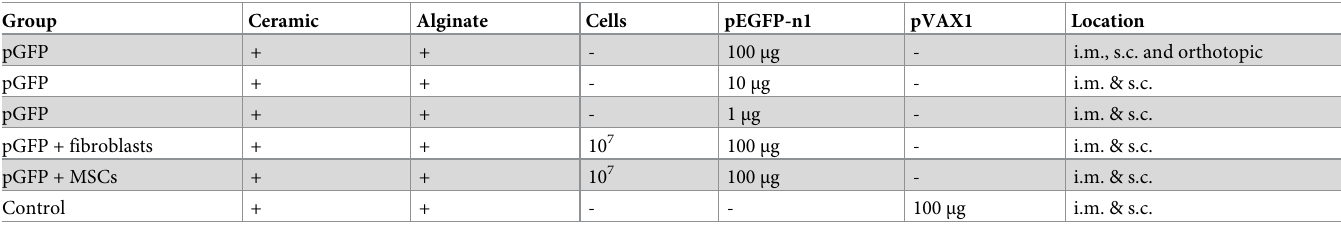
Table 1. Experimental groups for gene tracing study using pGFP (two weeks in rats).